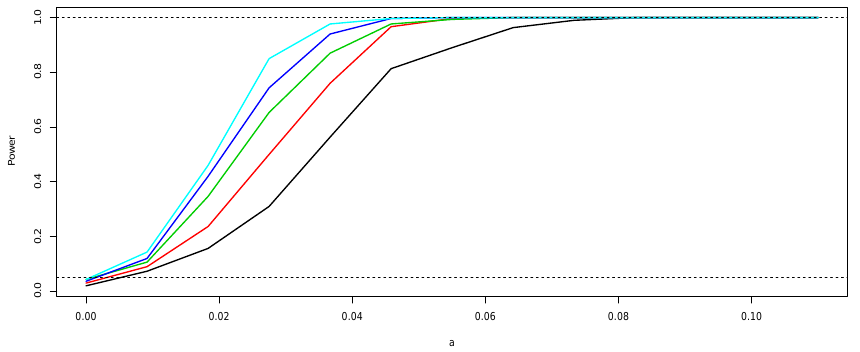
Figure 2. Empirical power of the sign test according to a ( t ) = a and n . The black curve corresponds to the power of the test for n = 50 and the light blue curve to the case of n = 150. The other curves correspond to n = 80 (red), n = 100 (green), and n = 120 (dark blue).